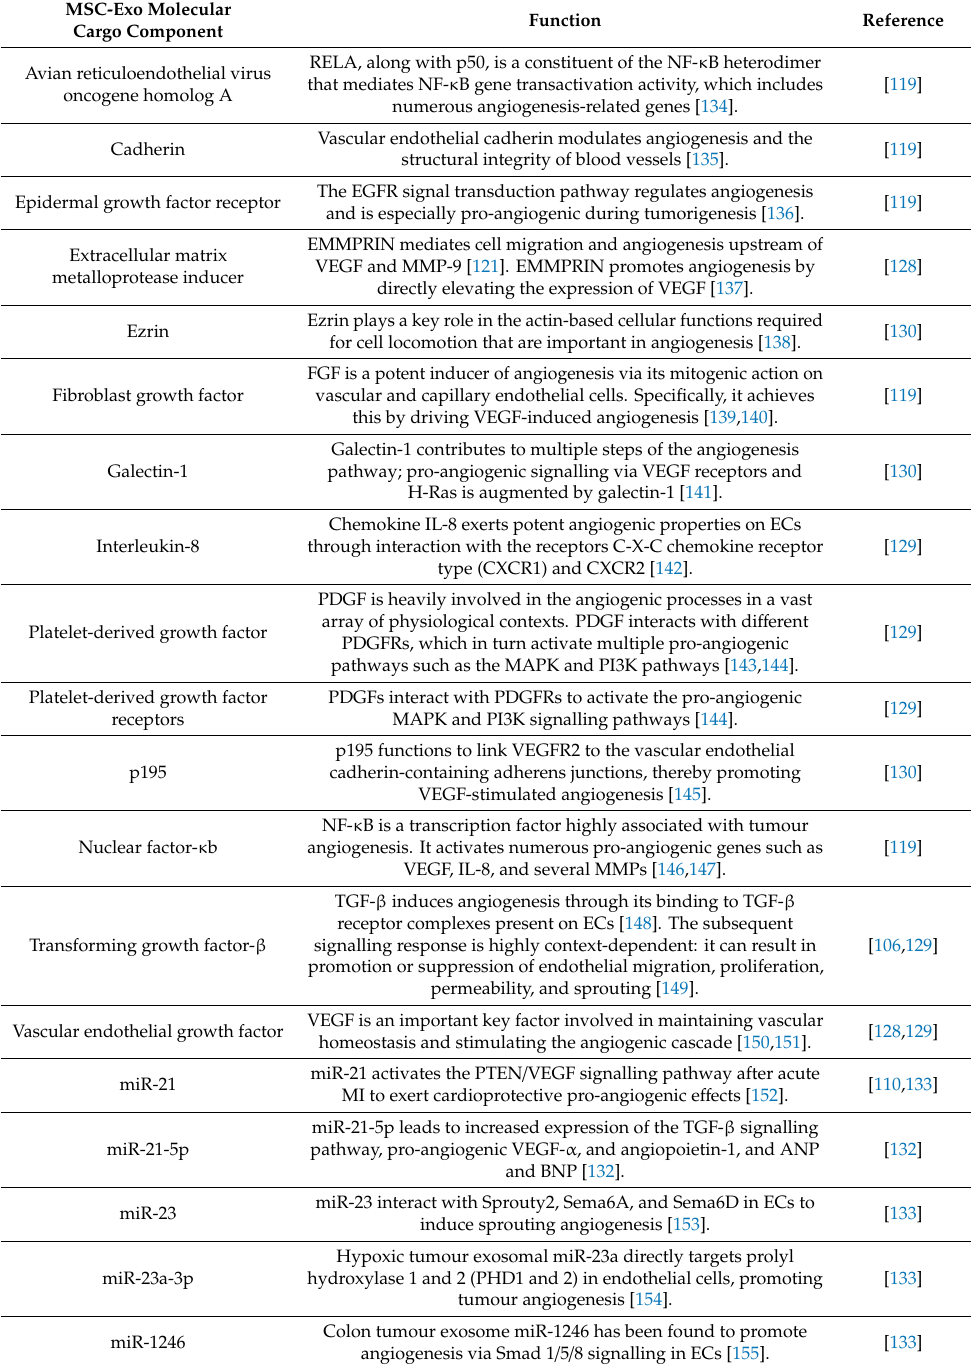
Table 1. List of components of the mesenchymal stem cell-derived exosomes (MSC-Exos) molecular cargo selected for their known potential to regulate the angiogenesis